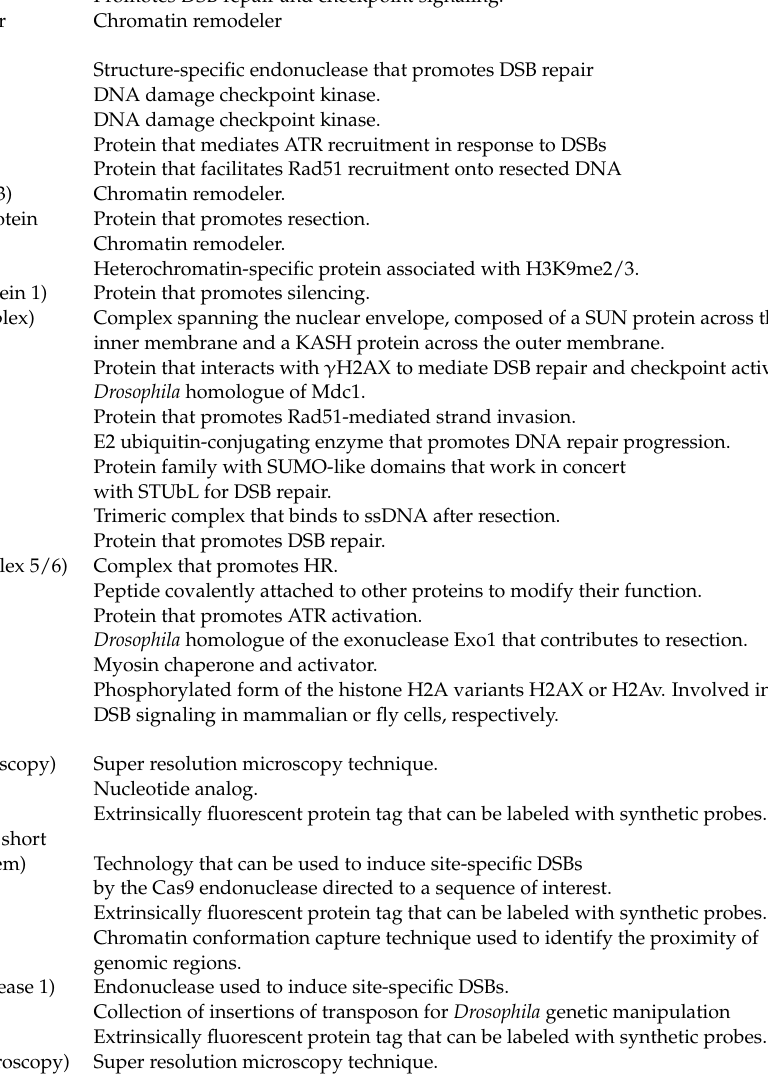
Assay to detect DNA